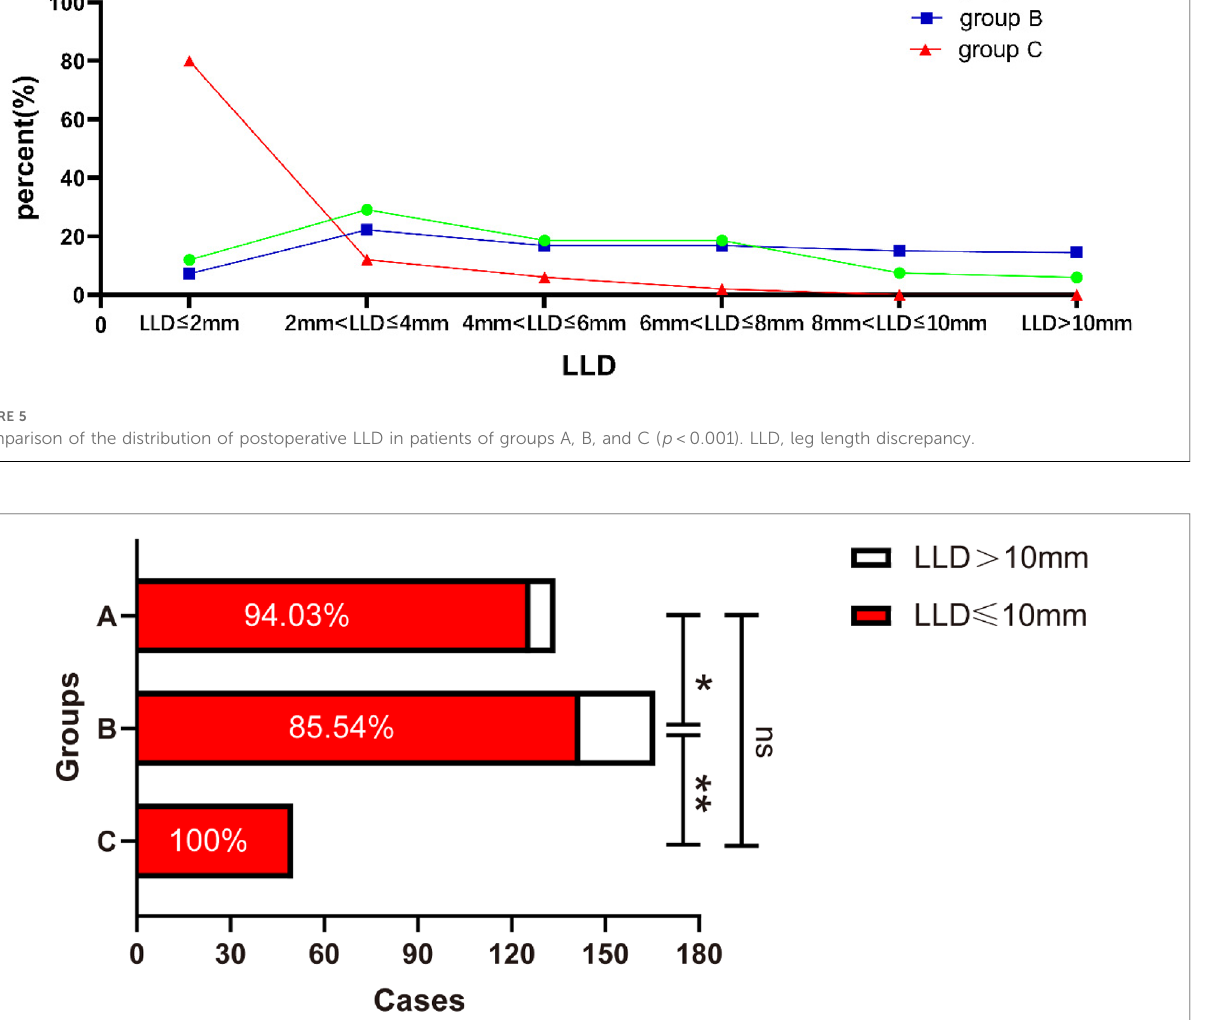
FIGURE 6 Comparison of the proportion of postoperative LLD>10 mm in patients of groups A, B, and C (* p <0.05, ** p <0.01; ns indicates no signi fi cance). LLD, leg length